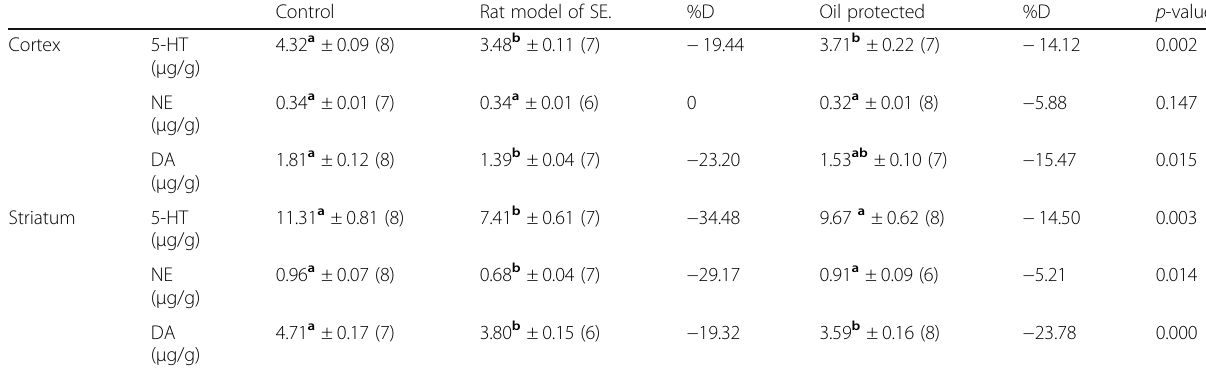
Values represent mean±S.E. with the number of animals between parentheses % D: % difference with respect to control values Different letters indicate significantly different means at p -value <0.05 Same letters indicate non significant